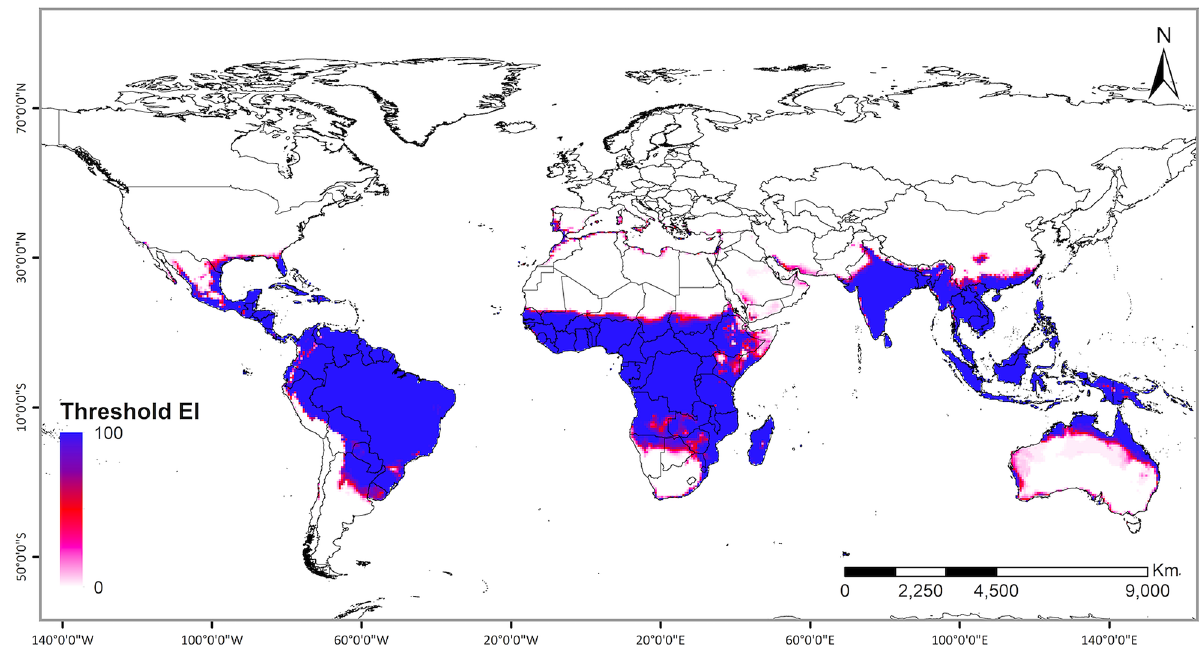
Figure 6. CLIMEX model uncertainty analysis. The proportional model agreement (%) for sampled parameter uncertainty. ArcMap 10.8 (https:// deskt op. arcgis. com/ en/